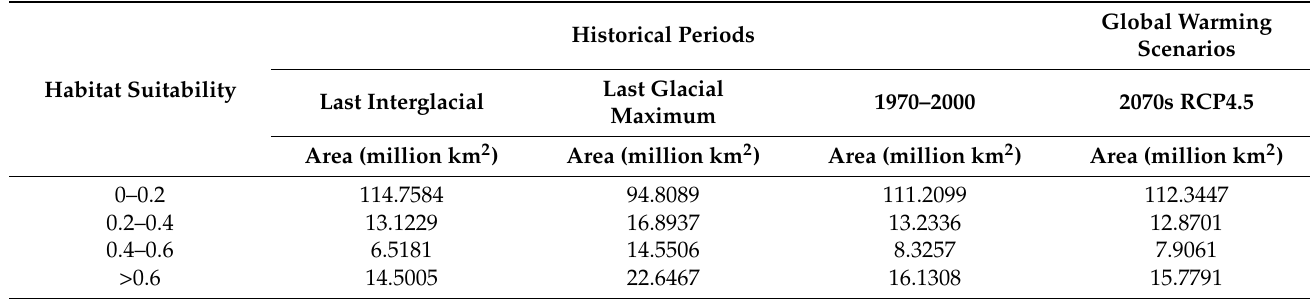
Table 4. The area of Panorpidae’s four habitat suitability distribution over four eras.